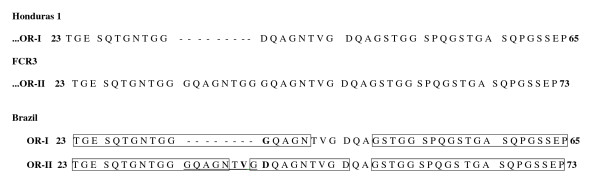
Alignment of the predicted amino acid sequences of P126 OR region from Candeias do Jamari and Peixoto de Azevedo P. falciparum isolates (GenBank accession number EU360815 and EU360816). The OR fragments OR-I and OR-II from Brazil were compared one each other and to FCR3 and Honduras1 OR described sequences reported by Morimatsu and others [22] and Liu and others [35]. The motif insertion is underlined, the lake of corresponding residues is indicated by dash, different residues are indicated in boldface letters and two (OR-I) or three (OR-II) antigenic determinants are in box.